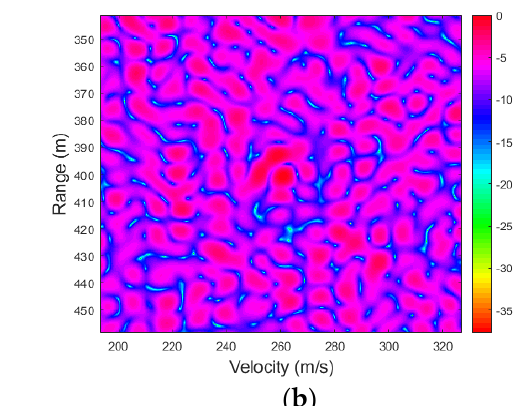
Figure 7. Normalized range-velocity image of three clustered targets with R = [400 m, 400 m, and 394 m] and V = [260 m/s, 253 m/s, and 260 m/s], level in dB ( a ) Using the SDFnT-based method ( b ) Using the 2D-FFT method.